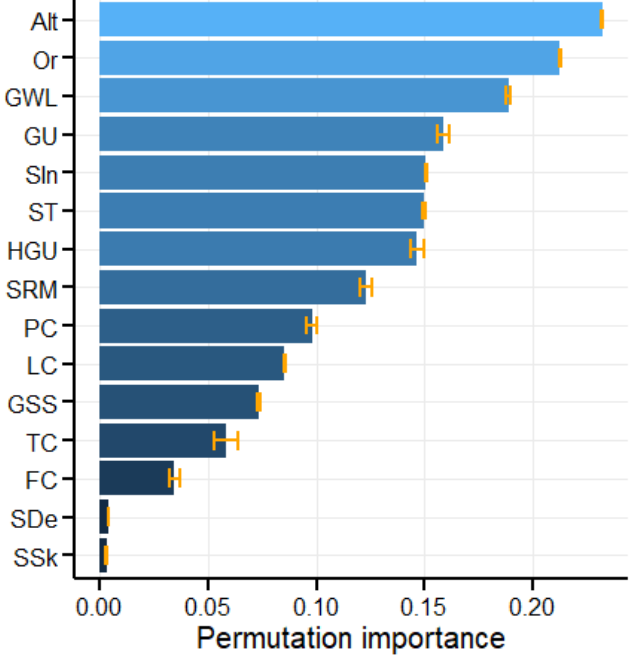
Figure 8. The average permutation importance of variables. Bars indicate standard deviation of the permutation importance across the 5 folds of the